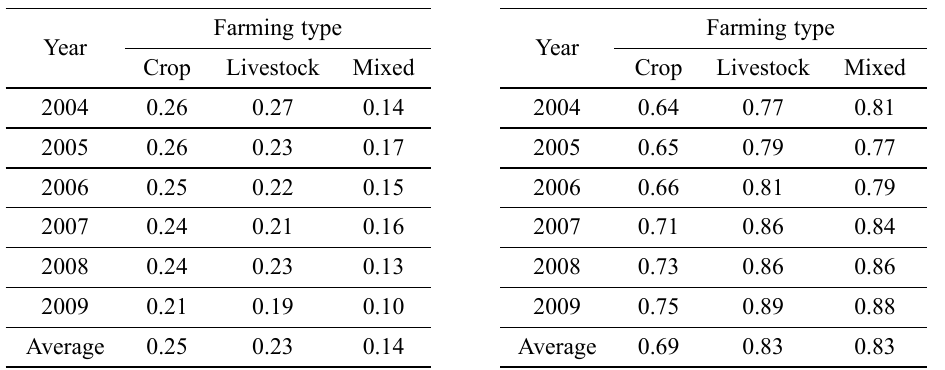
Table 3. Output elasticity with respect Table 4. Output elasticity with